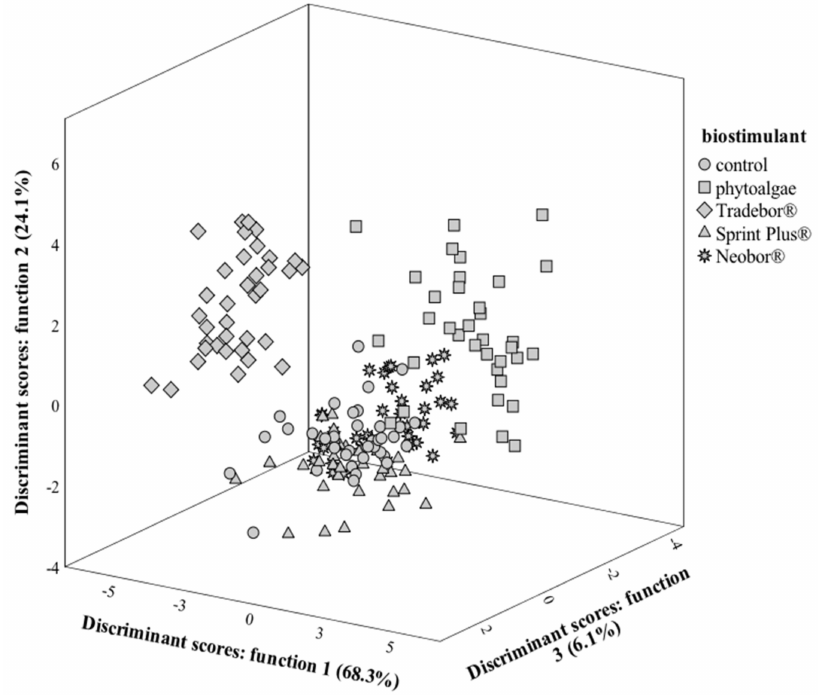
Figure 1. Spatial distribution of almond crop biostimulant markers according to the discriminant functions coefficients. Function 1 accounted for 68.3% of the variation, function 2 accounted for 24.1%, while function 3 accounted for